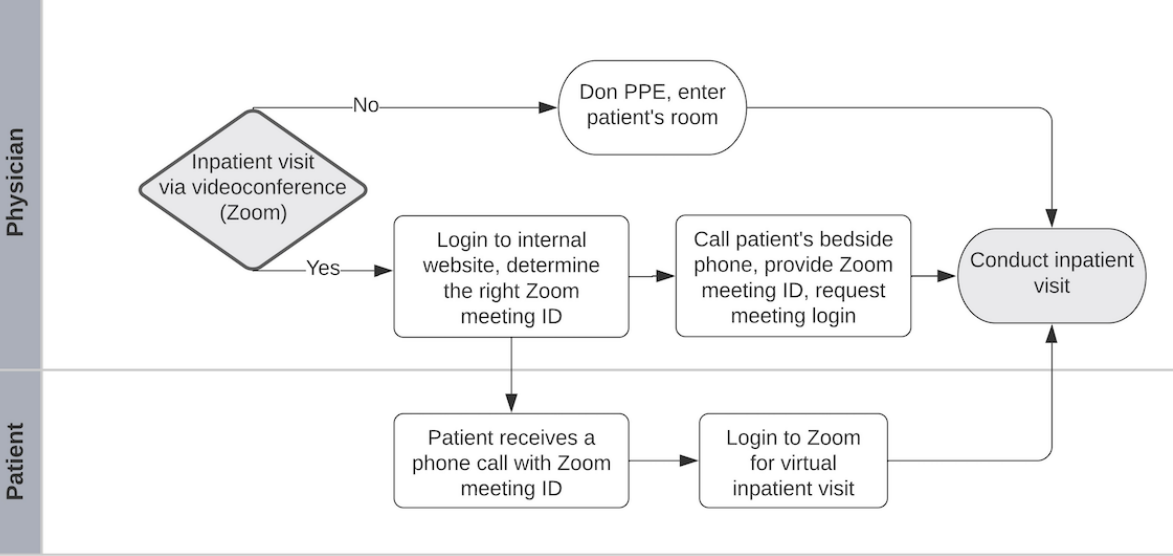
Figure 1. Process flow for inpatient video call at an academic medical center in San Diego, CA. PPE: personal protective